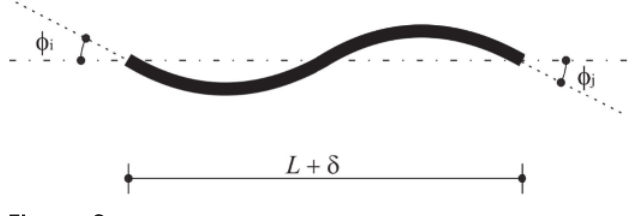
Figure 2 Generalized strains of the finite element